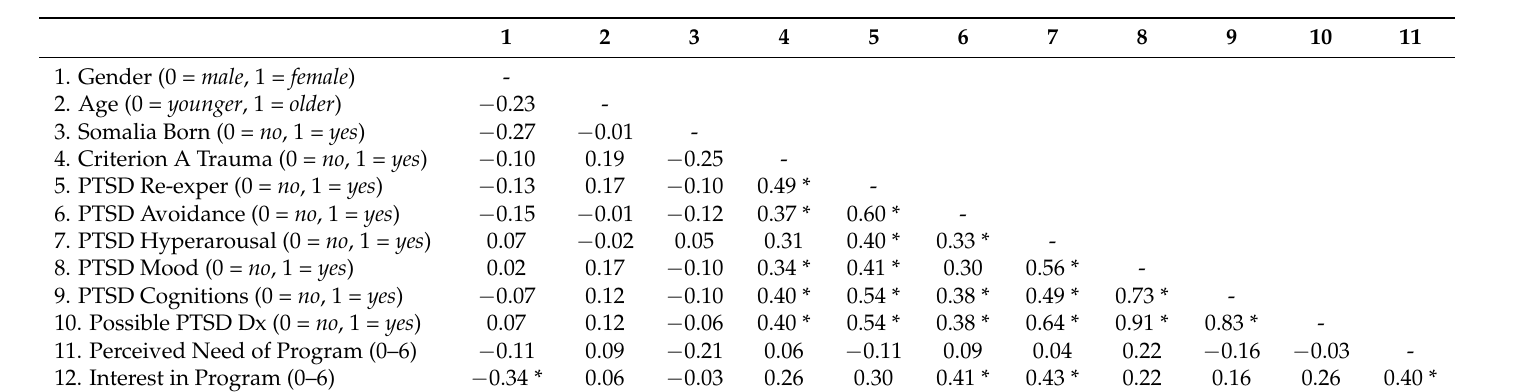
Table 1. Correlations among Demographic Factors, PTSD Symptoms, and Perceived Program